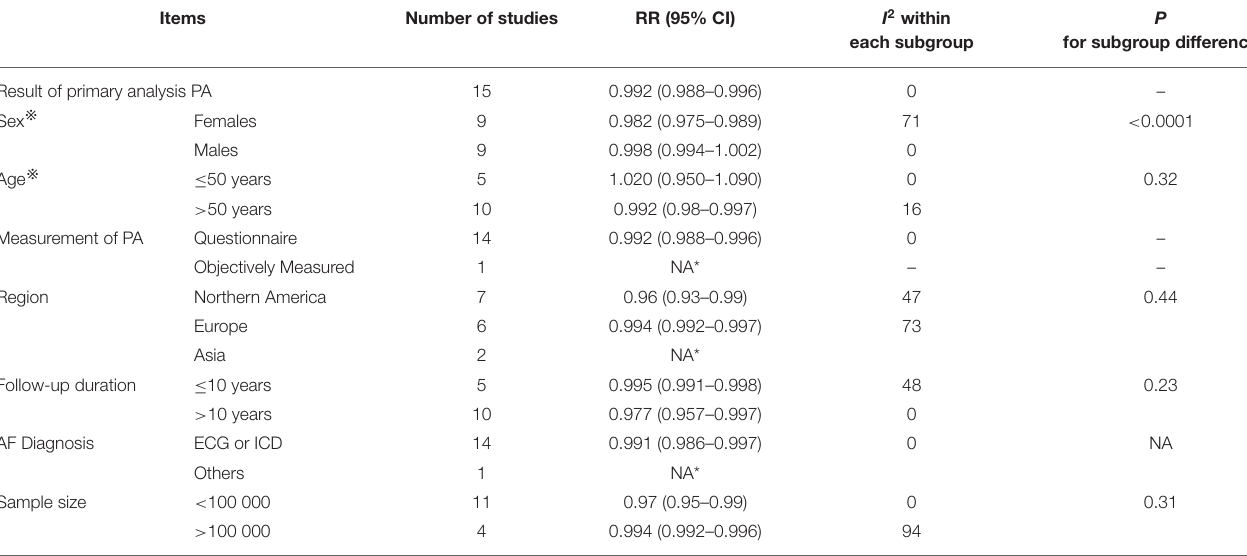
P each subgroup for subgroup difference